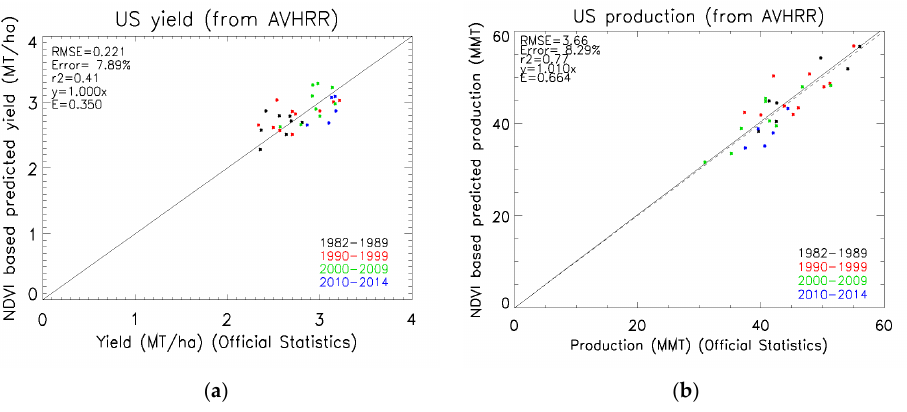
Figure 9. National winter wheat predicted yield ( a ) and production ( b ) in the U.S., applying the ‘original’ method [1] to AVHRR data plotted against USDA-reported statistics (https://quickstats.nass.usda.gov).